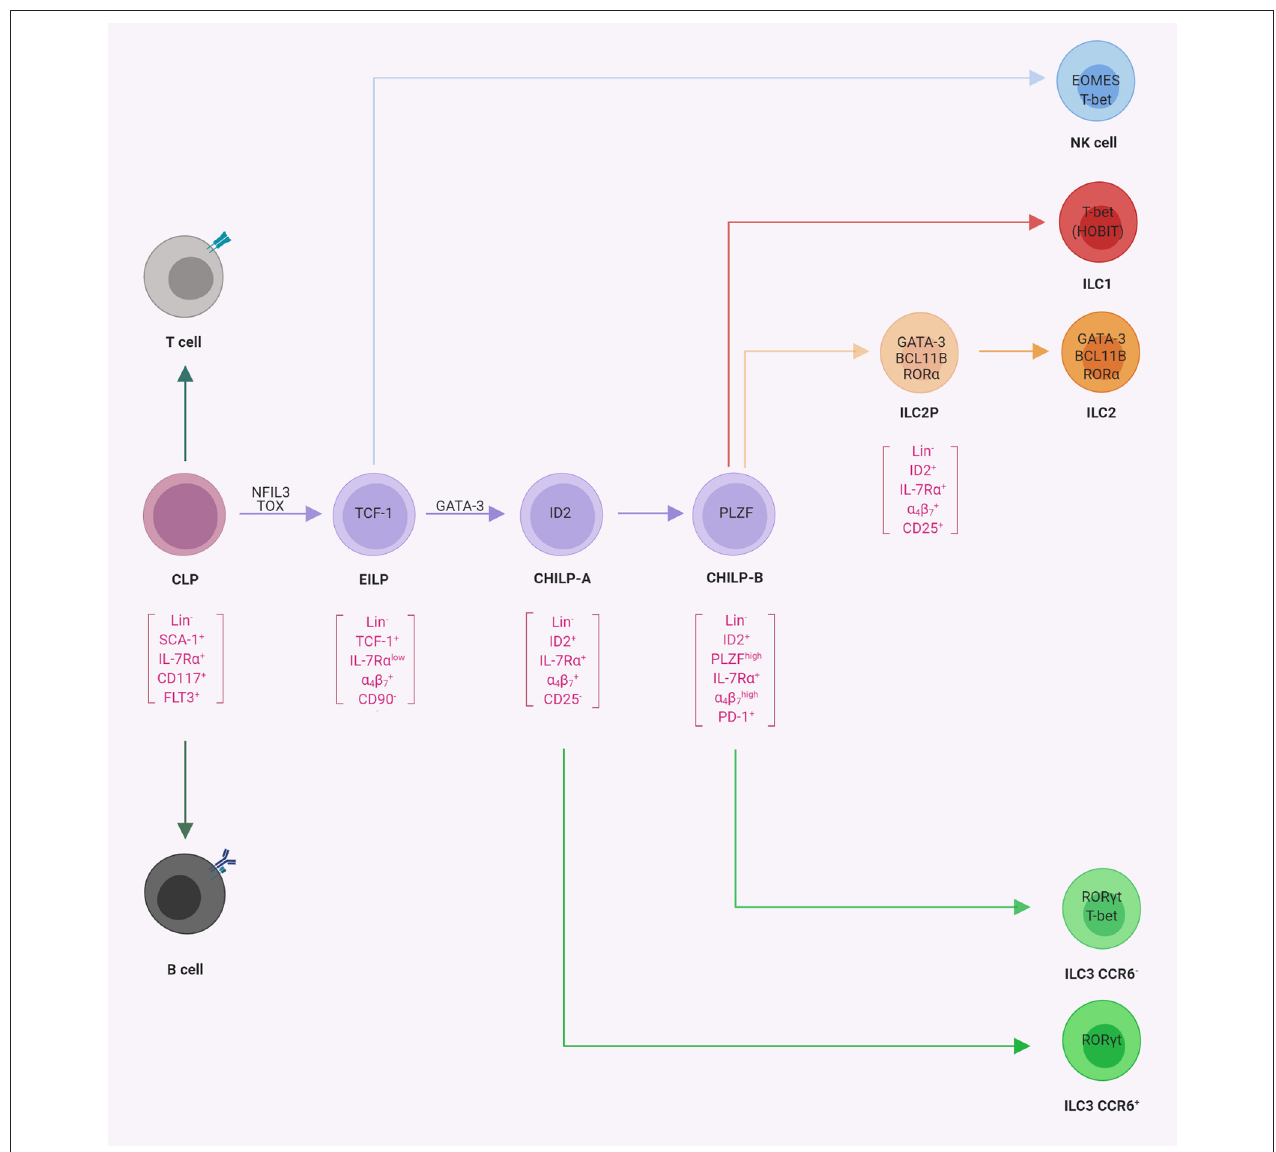
FIGURE 2 | Progenitor commitment to innate lymphoid cells (ILCs). Schematic representation of progenitor populations with various differentiation potentials toward ILCs. The common lymphoid progenitor (CLP) gives rise to B-cells, T cells, and ILCs. The early innate lymphoid progenitors (26) possess the potential for NK cells, ILC1s, ILC2s, and ILC3s, whereas CHILP-A (21) and CHILP-B (98) possess the potential for ILC1s, ILC2s, and ILC3s as indicated. In square brackets are the population-defining markers reported in the literature. The transcription factors required for the indicated lineage or transition from one population to another are indicated within the cells or on the arrows, respectively (illustrations created with